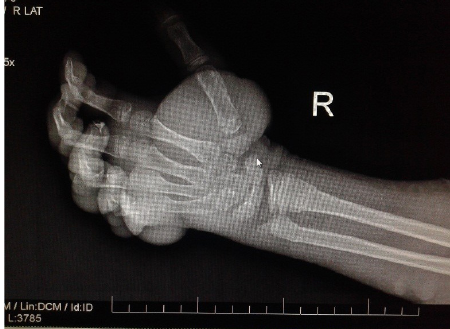
Figure 2. The very large blisters in the left dorsal forearm and hand.